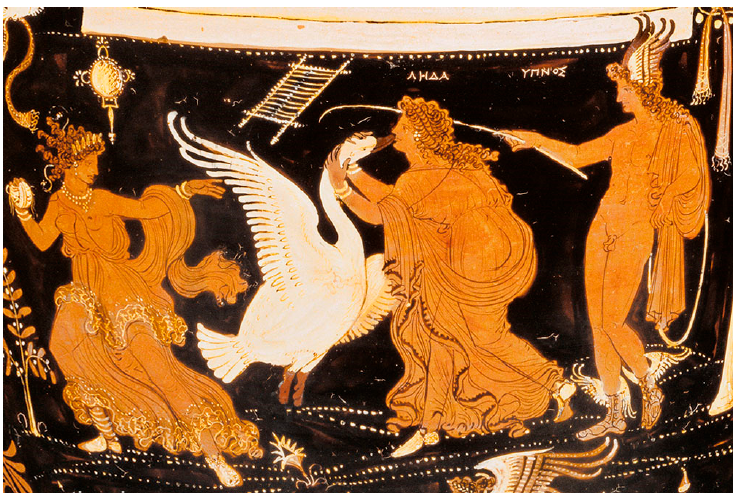
Figure 1. Apulian red-figure loutrophoros of Leda and the Swan , C4th B.C., © The J. Paul Getty Museum, Malibu.